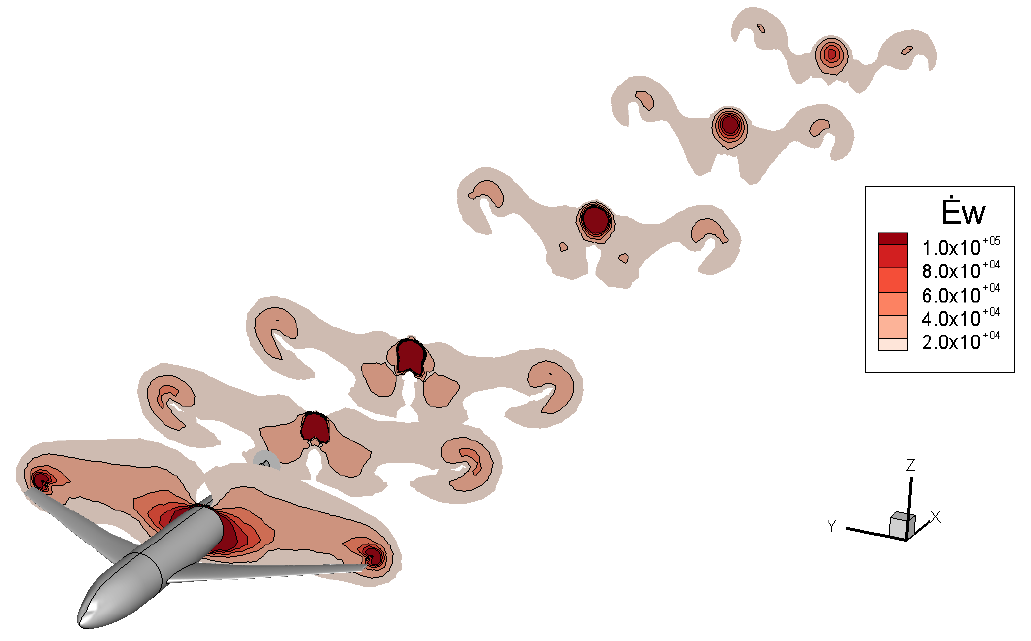
• Figure 15. Contours of ˙Ew integrand around the BLI Figure 15. Contours of E w integrand around the BLI configuration.